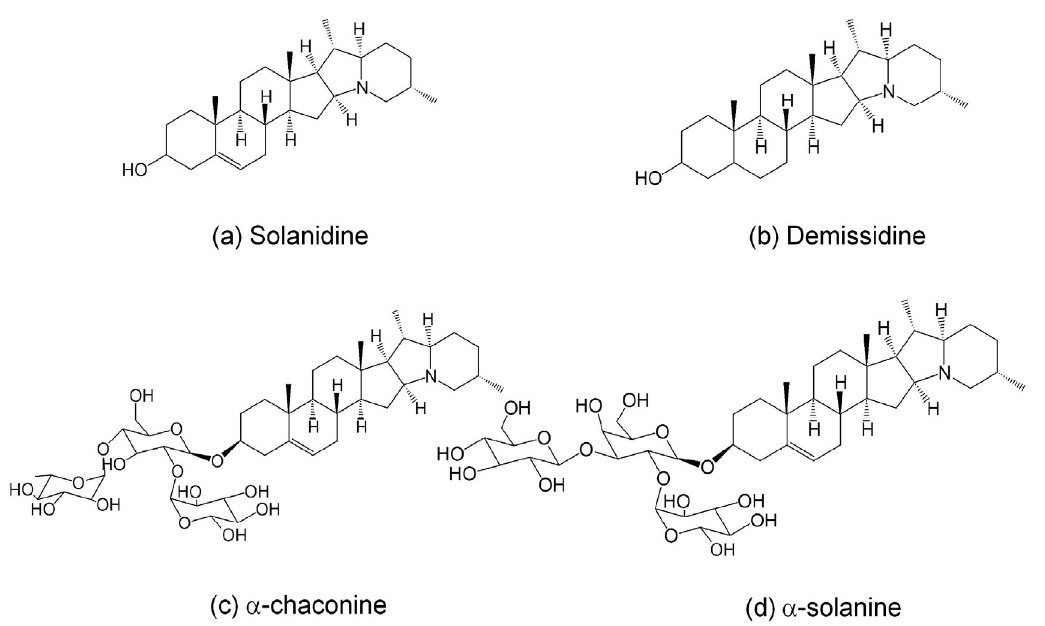
Figure 1. Chemical structures of glycolkaloids in potato